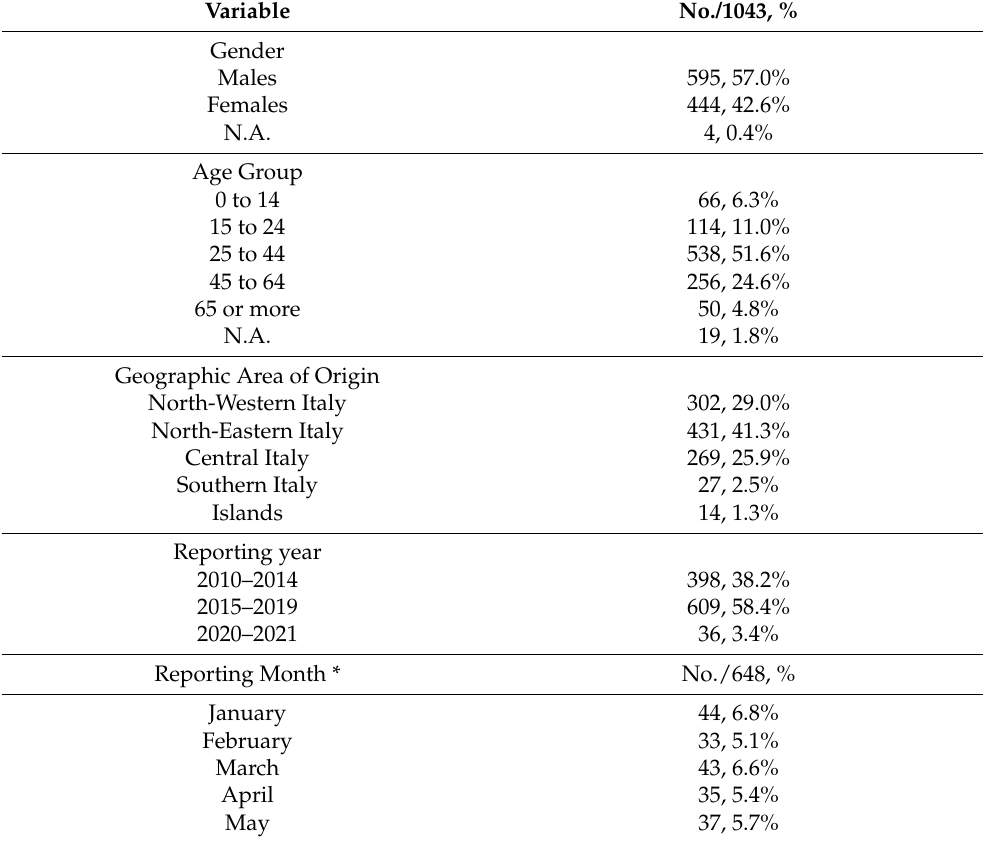
Table 1. Summary of notified cases of dengue in Italy